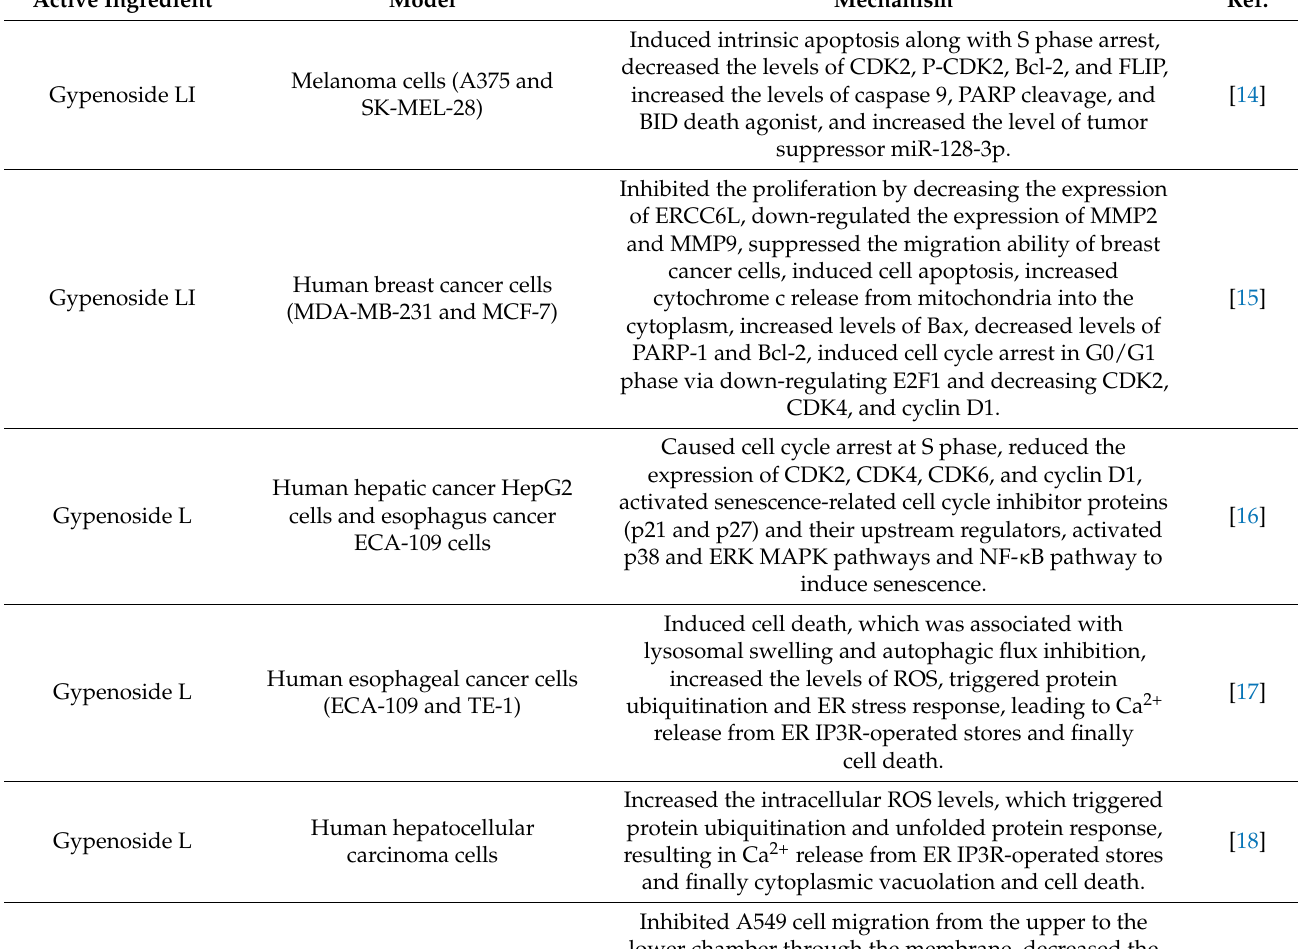
Table 1. Anti-cancer effect of